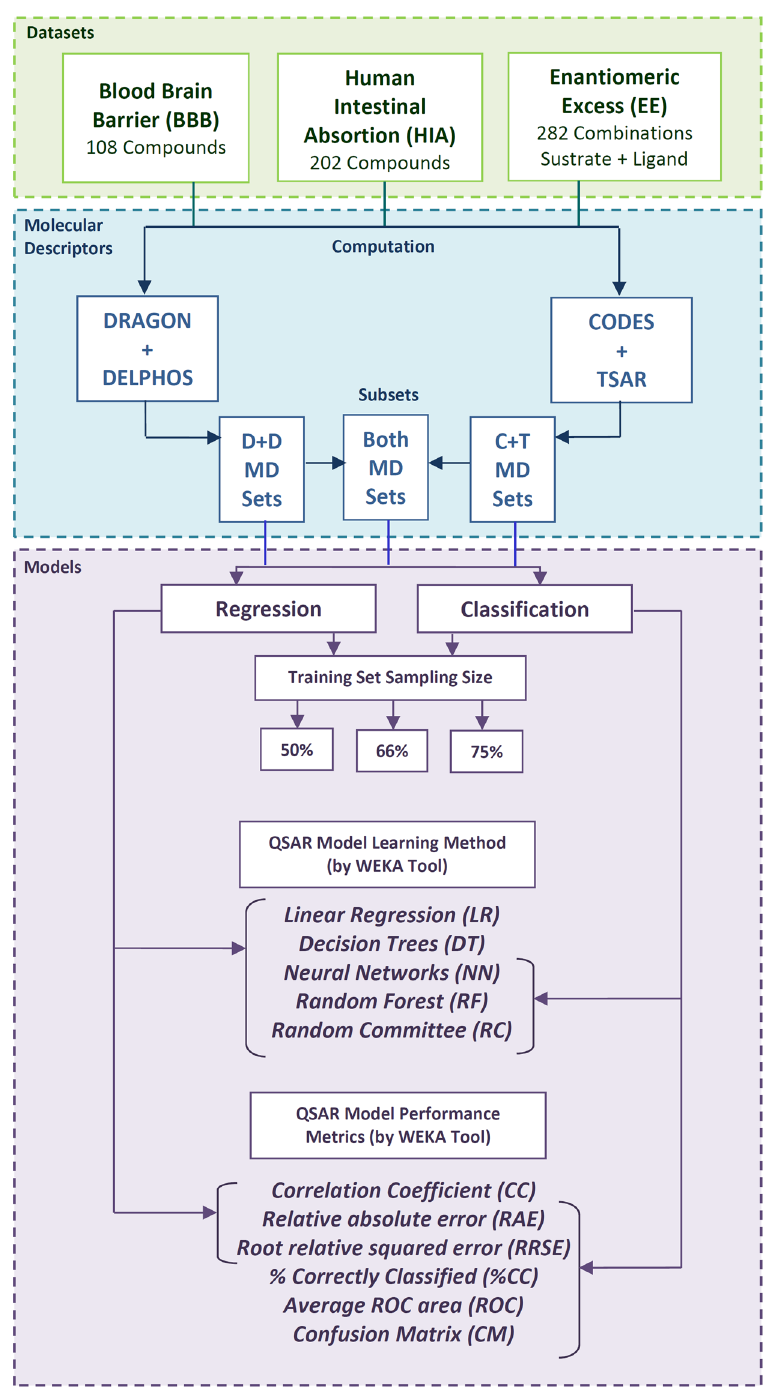
Figure 1. Scheme of the in silico experiments reported for the prediction of blood-brain-barrier (BBB), human intestinal absorption (HIA) and enantiomeric excess